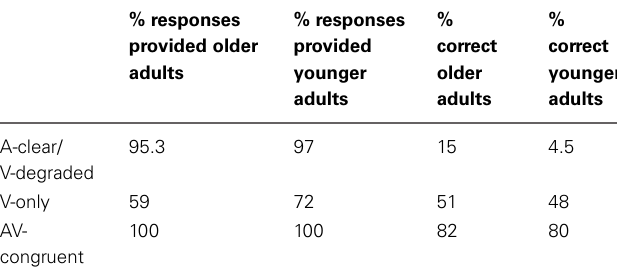
Table 1 | Percentage of responses provided and correct